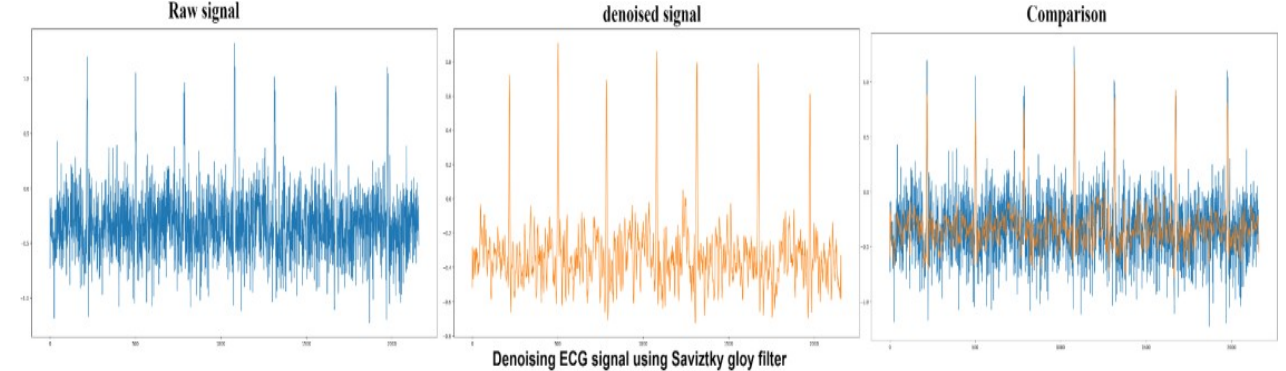
Figure 10. Raw ECG signal (Blue) denoising using Saviztky Golay filter and comparing denoised (Orange) and raw signals.